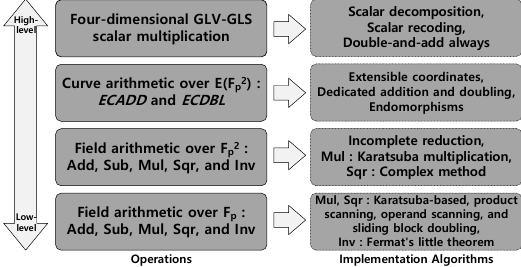
Figure 1. The implementation hierarchy of four-dimensional Gallant-Lambert-Vanstone and Galbraith-Lin-Scott (GLV-GLS) scalar